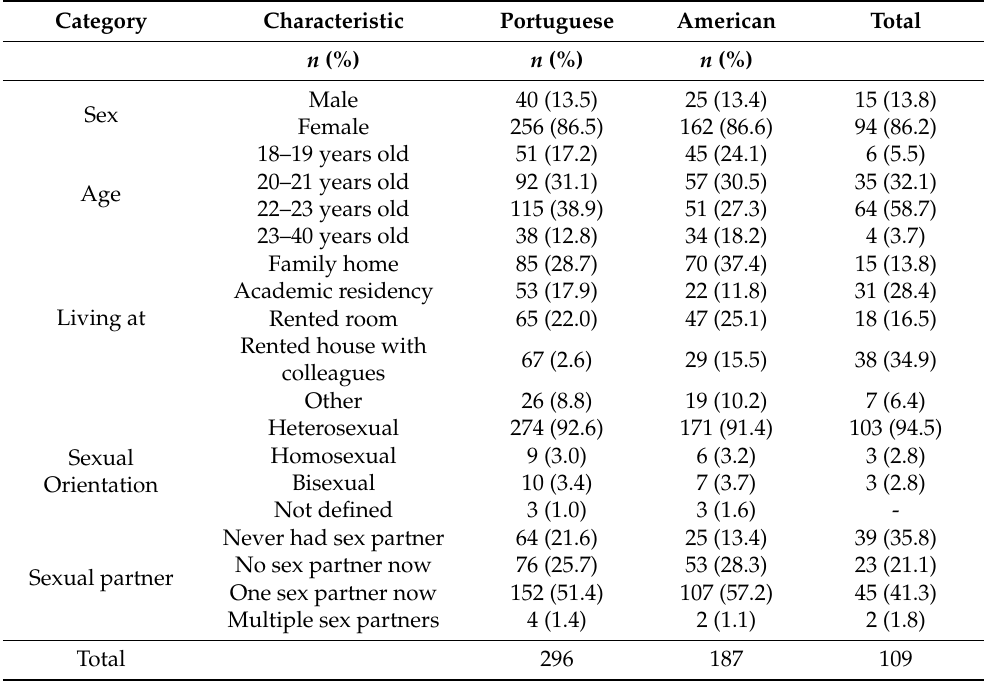
Table 1. Characteristics of the participants.